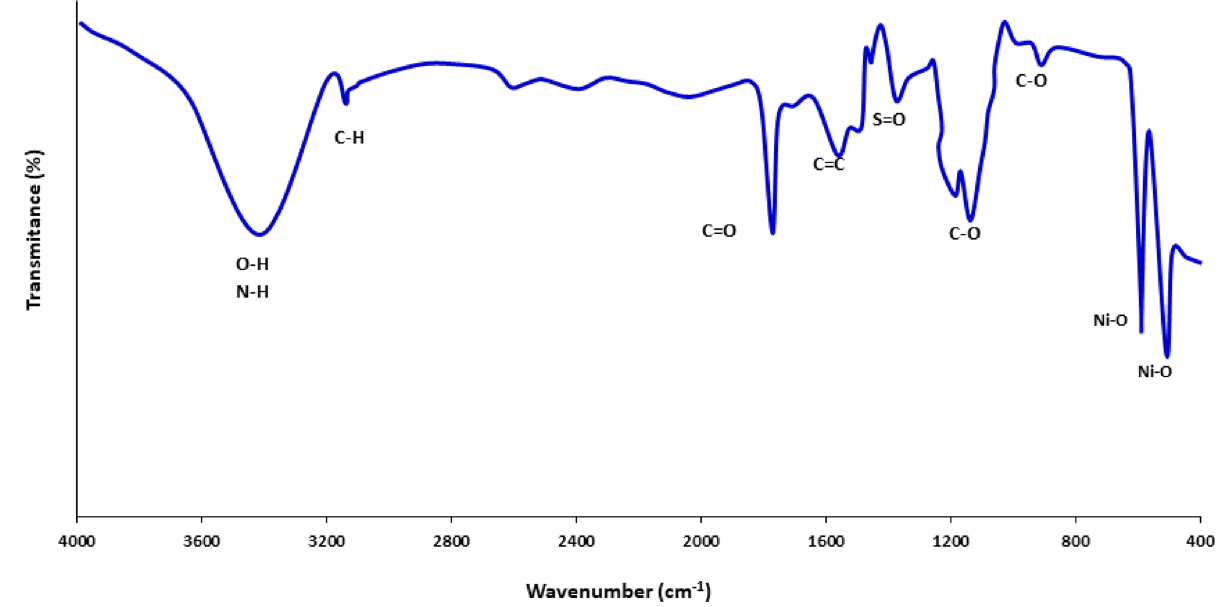
Figure 4. FTIR spectra of marine algae-mediated synthesized NiO NPs.